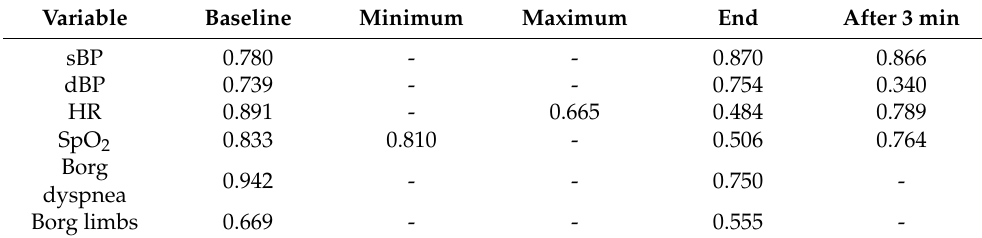
0.942 Borg limbs 0.669 0.555